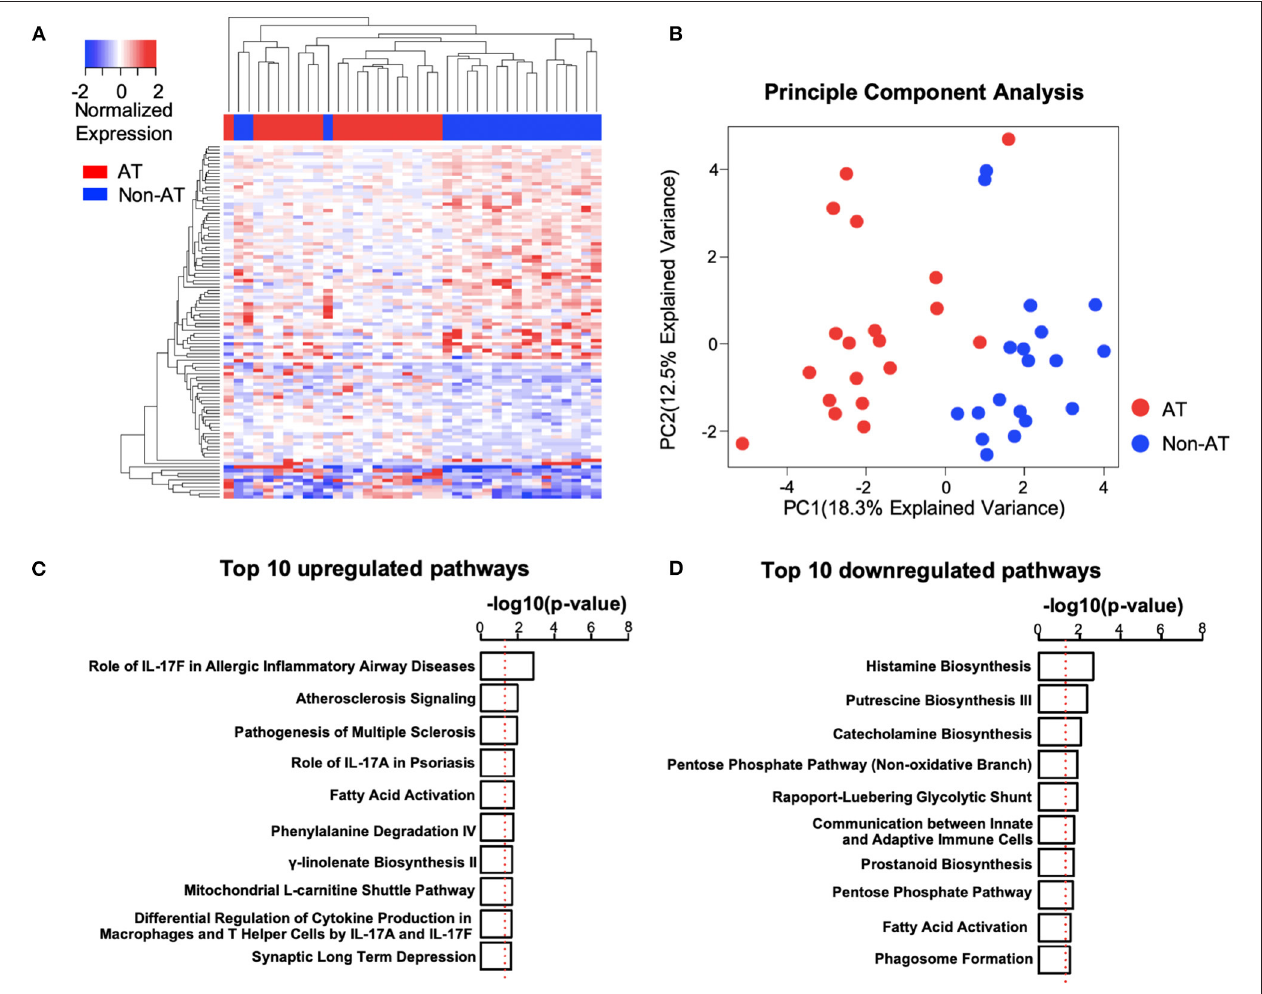
FIGURE 2 | Systemic lupus erythematosus (SLE) atherosclerosis (AT) group has activated atherosclerosis signaling and interleukin (IL)17-related immune pathways. (A,B) Heatmap (A) and principal component analysis (PCA) plot (B) of differentially expressed (DE) genes. The clustering of genes and patients in heatmap was based on complete-linkage, Euclidean distance hierarchical clustering. Red, AT. Blue, Non-AT. (C,D) Top 10 upregulated (C) and downregulated (D) pathways in SLE AT group. Ranked by –log 10 ( p -value). –log 10 (0.05) is marked with a red line. Ingenuity Pathway Analysis (IPA) was performed with upregulated ( n = 39) and downregulated ( n = 67) DE